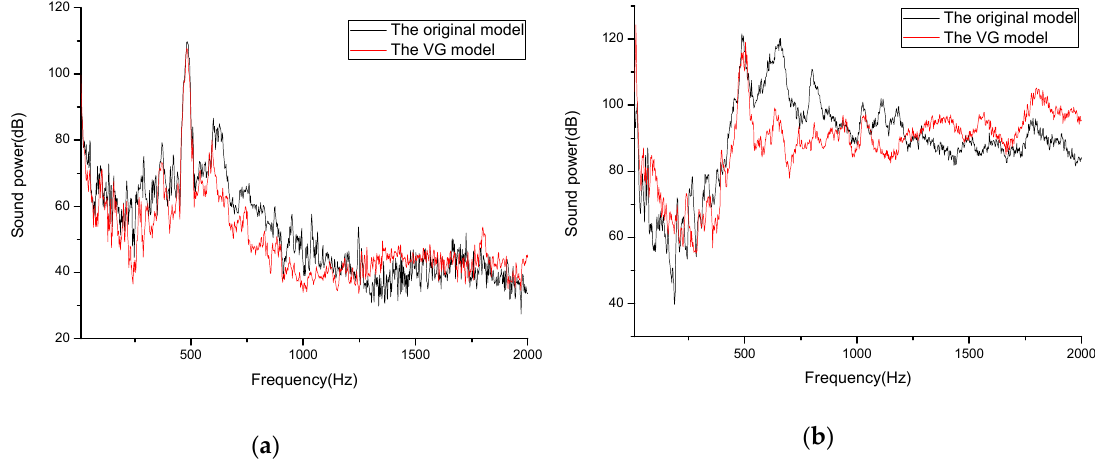
Figure 28. The radiated sound power measured by the vertical hydrophone array in the reverberation tank at different flow velocities: ( a ) 4.62 m/s; ( b ) 8.68 m/s.